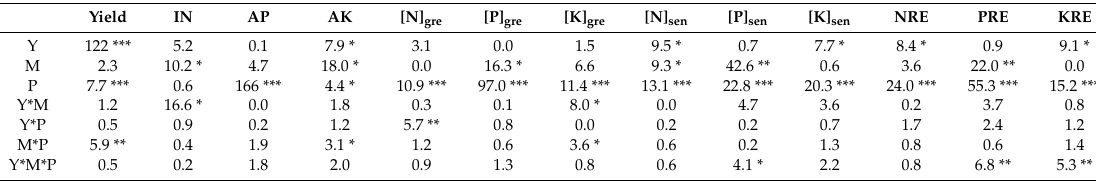
Table 1. Results of linear mixed models analysis of variance on the e ff ects of film mulch (M), P fertilization (P), and cropping year (Y), and their interactions on forage yield, inorganic nitrogen (IN), available phosphorus (AP), and available potassium (AK) in soil, nutrient concentrations in mature and senescent leaves, and nutrient resorption e ffi ciency. Yield IN